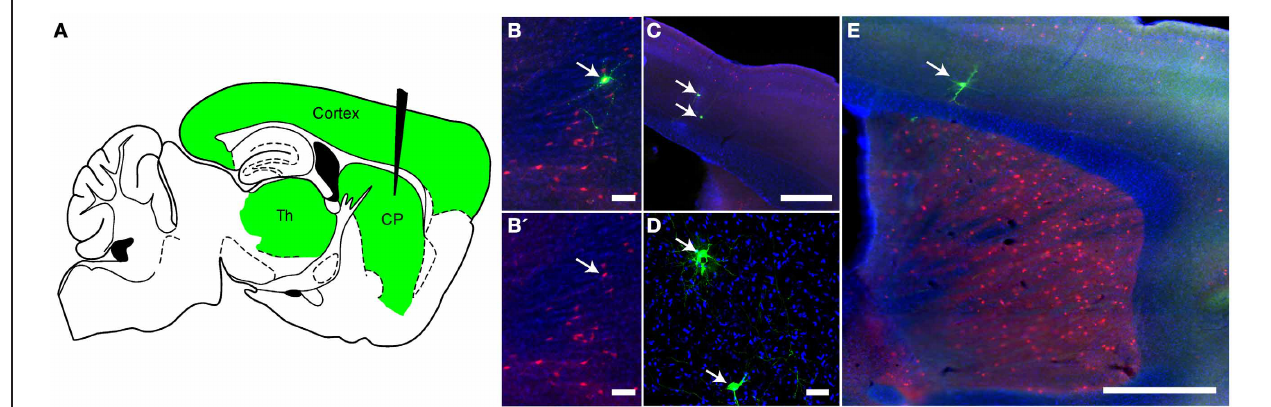
FIGURE 7 | Monosynaptic retrograde tracing using rVSV in vivo . (A) A schematic of a parasaggital section showing the predicted pattern of monosynaptic retrograde spread from Choline Acetyltransferase (ChAT)-expressing neurons in the CP to directly connected cells. A combination of two Cre-dependent adeno-associated viruses (AAVs), one expressing a TVA-mCherry fusion protein and the other RABV-G, were injected into the CP of ChAT-Cre/Ai9 animals. This permits expression of the transgenes encoded in the AAVs in cells with a ChAT expression history. Two weeks later, rVSV (cid:2) G(A/RG), a G-deleted virus that only infects TVA-expressing neurons, was injected into the same region, and the brain